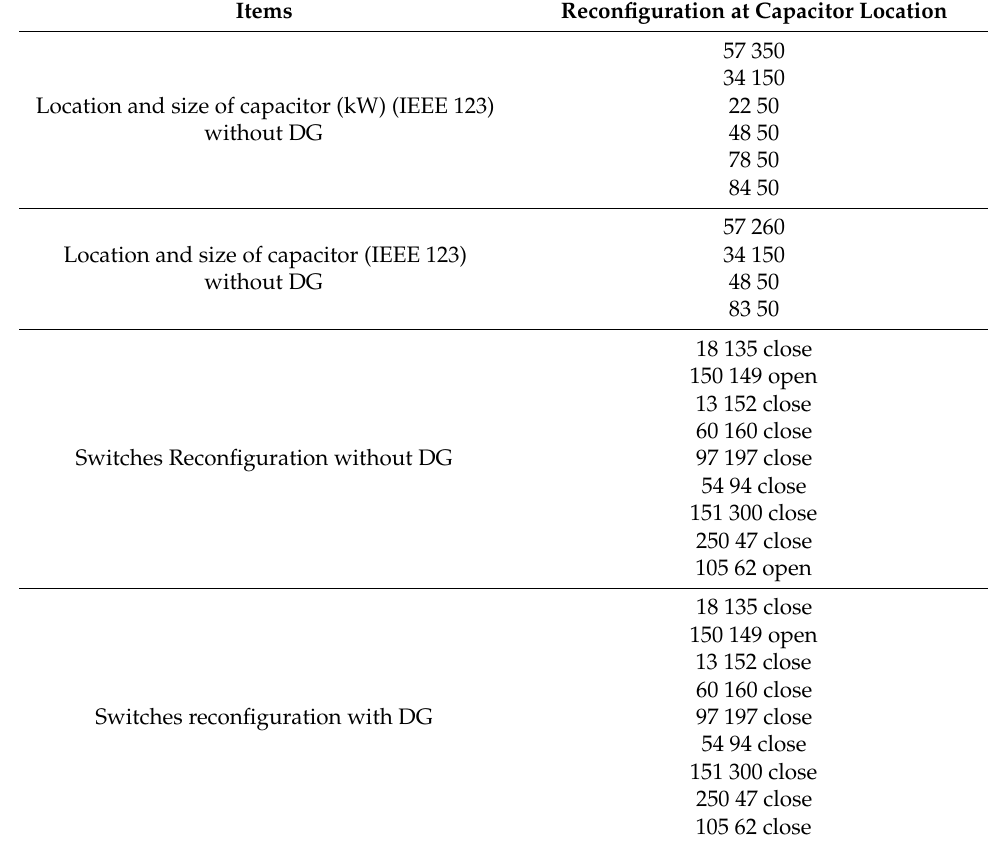
Table 11. Output of the proposed method for the IEEE 123 system.